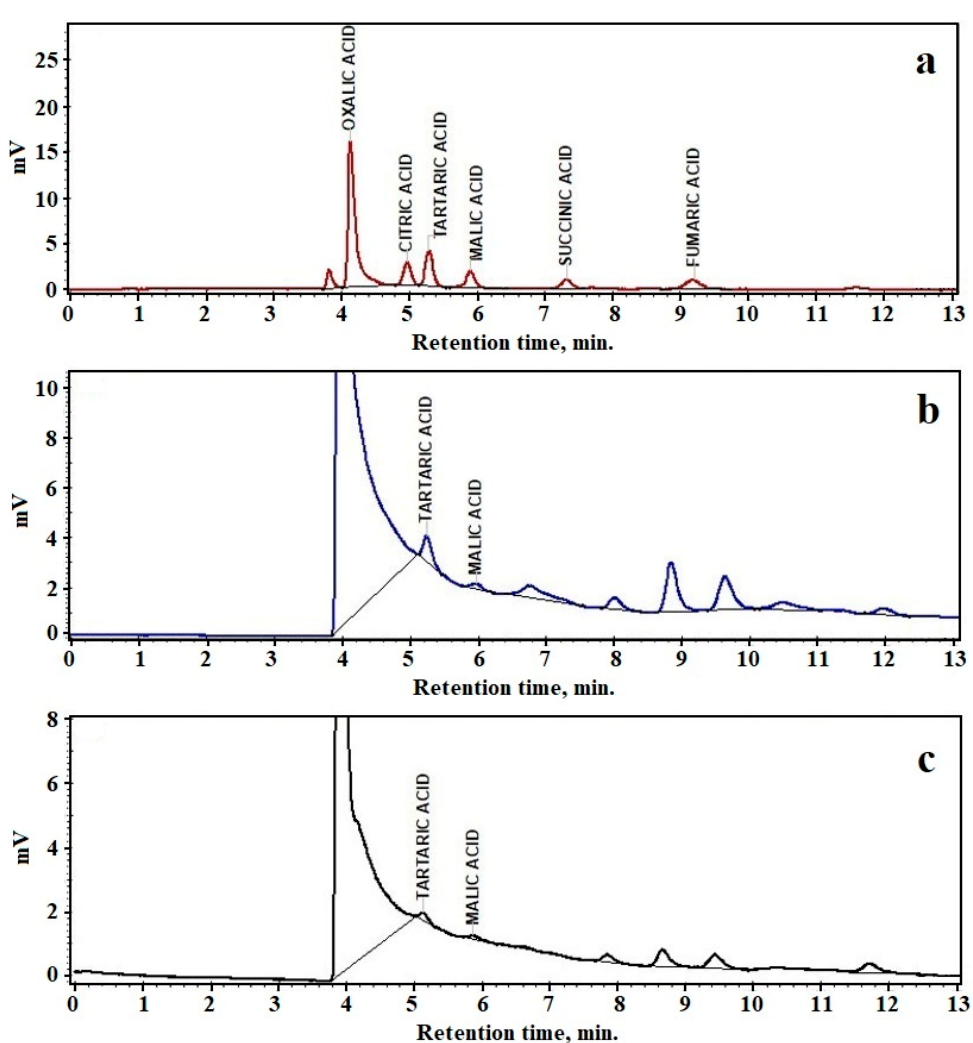
Figure 12. HPLC chromatograms: ( a ) standard reference, ( b ) Sample 1 and ( c ) Sample 3.